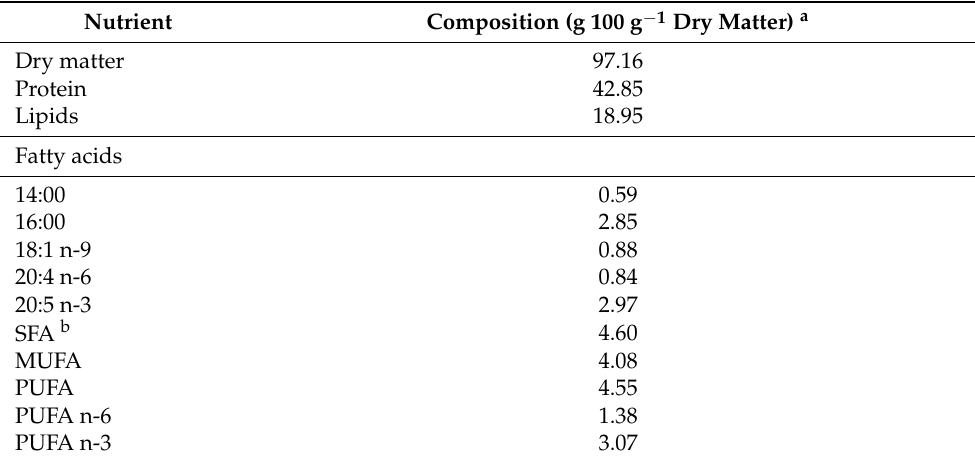
Table 1. Proximate composition and nutritional information of Nannochloropsis spp. meal, including the most representative fatty acids.